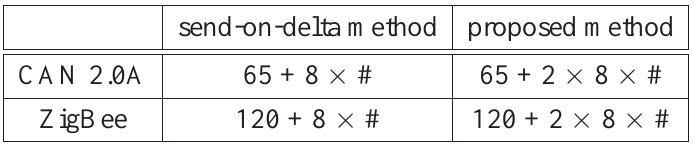
Table 5 . Total number of transmitted bits computation formula